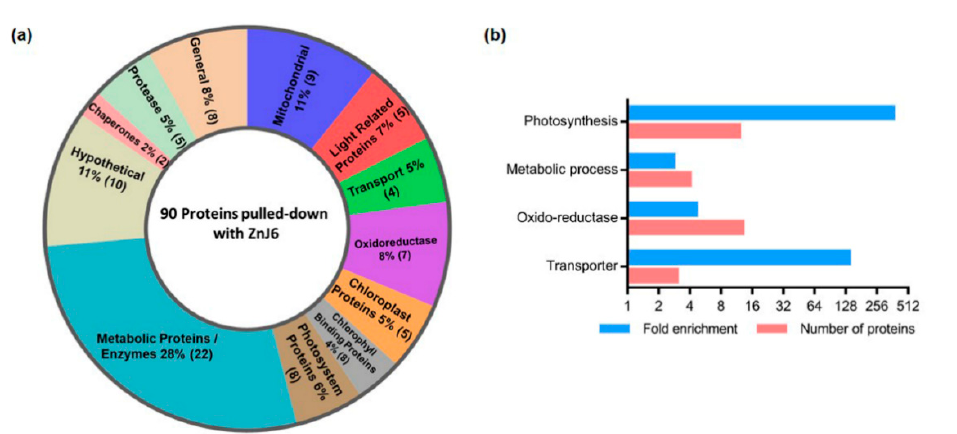
Figure 7. Protein categories associated with ZnJ6 in pull-down assays. The proteins pulled down with ZnJ6 were determined by LC–MS/MS analysis in triplicate and compared to control pull-down assays performed with a non-related maltose- binding protein (MBP) protein that was treated similarly. The proteins were identified by the MaxQuant software using Phytozome database annotations. Differences between the proteomic contents of the ZnJ6- and MBP-pulled-down fractions were determined using the Perseus statistical tool. Proteins with eight-fold enrichment compared to the control, with p < 0.05, were categorized. ( a ) Manual categorization of proteins into functional groups along with their relative abundance represented by the respective area (%) and the number of proteins (in brackets). The hypothetical group contains proteins with non-defined functions; ( b ) BLAST2GO enrichment was determined by the biological process with a minimum threshold of two-fold enrichment for the associated proteins compared to their gene abundance in the genome data